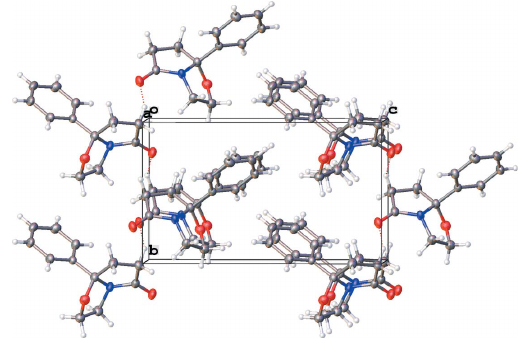
Figure 2 The packing of the title compound viewed down [100] showing hydrogen bonds as red dashed lines.